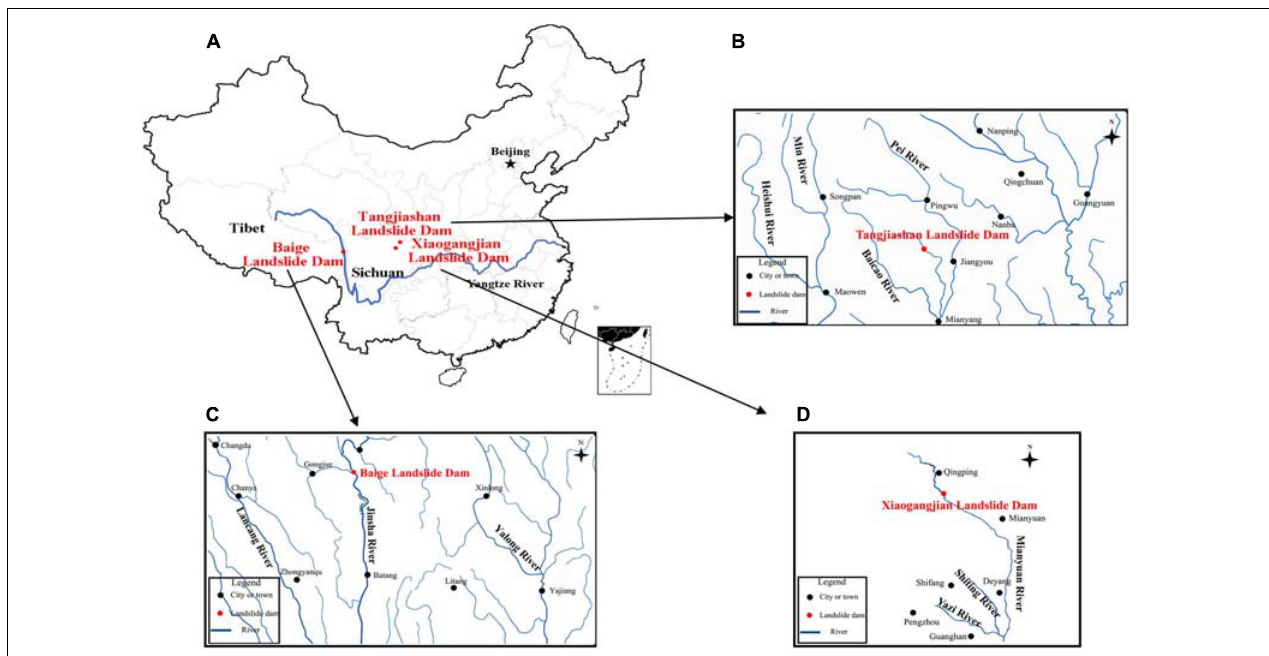
FIGURE 3 | The location of three representative landslide